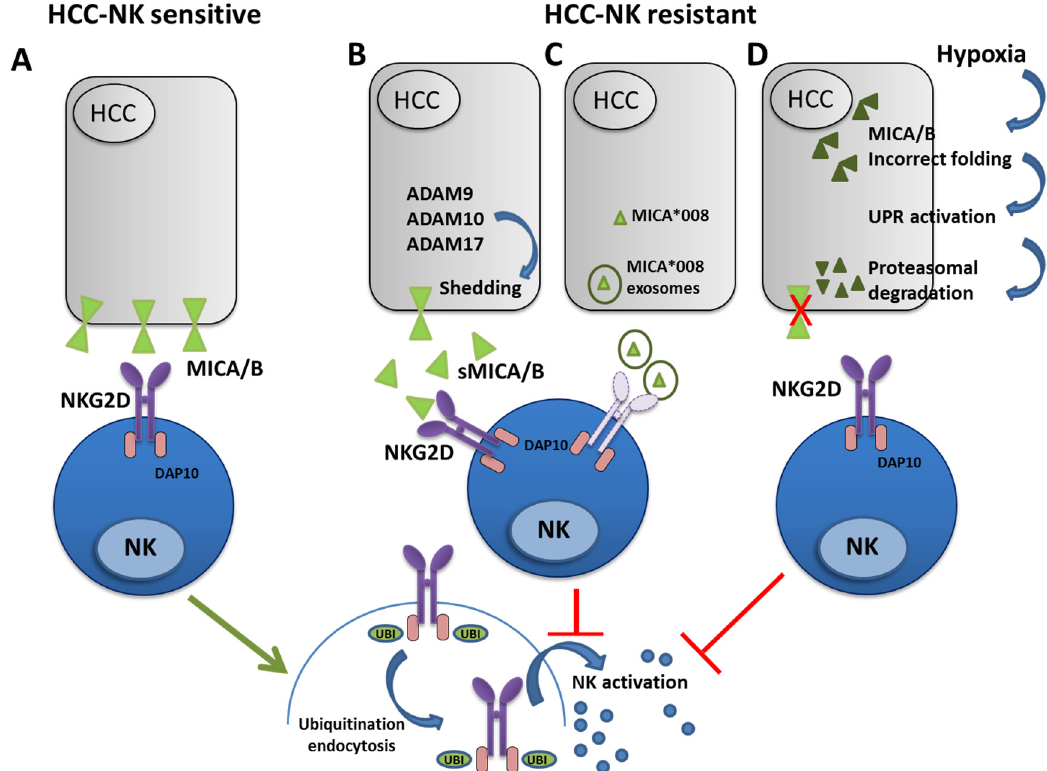
Figure 1. Hepatocellular carcinoma (HCC)-dependent alterations of the NKG2D-MICA / B axis. MICA / B molecules expressed on HCC cells are recognized by NKG2D receptor making them HCC-Natural Killer (NK) sensitive. This induces ubiquitination (UBI)-mediated endocytosis of NKG2D-DAP10 complex leading to NK activation and consequent HCC killing ( A ). In the right panels several mechanisms of evasion resulting in HCC being NK resistant are illustrated. ( B) sheddases ADAM9, 10 and 17 cleave MICA / B molecules producing the soluble form (sMICA / B) which binds NKG2D receptor. This blocks binding to membrane MICA / B with consequent NKG2D-mediated NK activation. ( C ) MICA release mediated by exosomes can downmodulate NKG2D and inhibit the NK cytotoxic e ff ect. ( D ) UPR-dependent proteasomal degradation of unfolded MICA / B proteins results in its reduced membrane expression. These mechanisms disrupt NK cell activation and anti-tumor response.